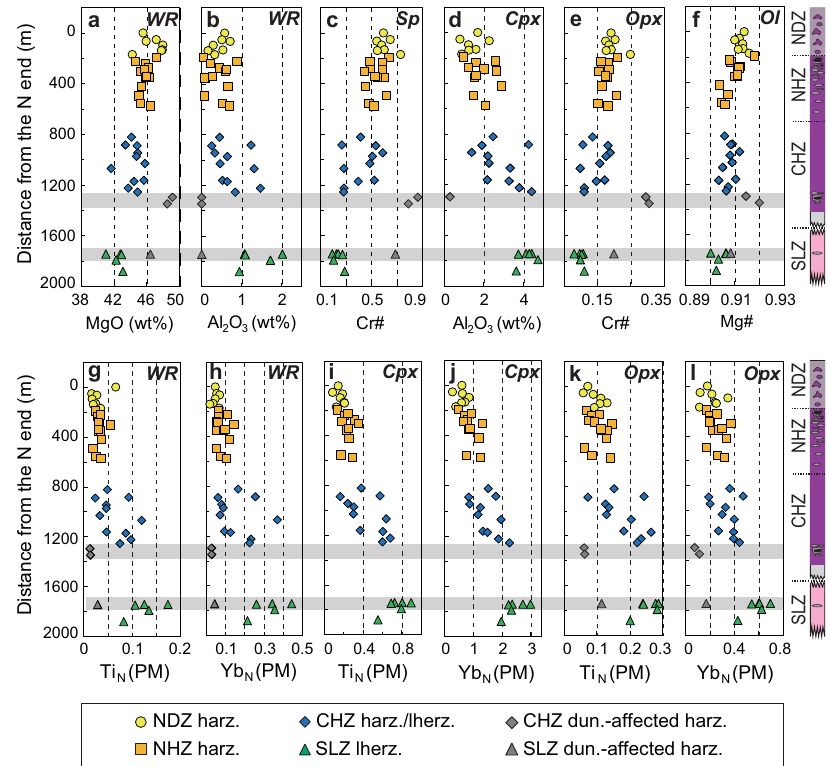
c spinel Cr# (Cr 3+ /(Cr 3+ +Al 3+ )), d clinopyroxene Al 2 O 3 (wt%), e orthopyroxene Cr#, f olivine Mg# (Mg 2+ /(Mg 2+ +Fe 2+ )), g whole-rock Ti N (PM, normalized to primitive mantle 70 ), h whole-rock Yb N (PM), i clinopyroxene Ti N (PM), j clinopyroxene Yb N (PM), k orthopyroxene Ti N (PM), and l orthopyroxene Yb N (PM). Two gray bands mark the local abnormally-depleted zones affected by melt-peridotite interaction during dunitization. WR, whole rock; Sp, spinel; Ol, olivine; Opx, orthopyroxene; Cpx, clinopyroxene; harz., harzburgite; lherz., lherzolite; dun.,